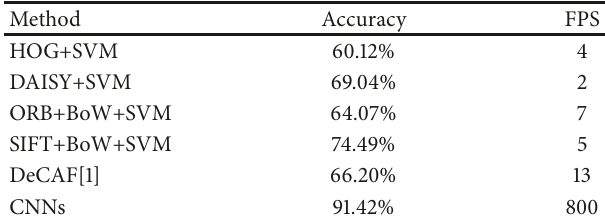
Table 2: Accuracy and FPS of different